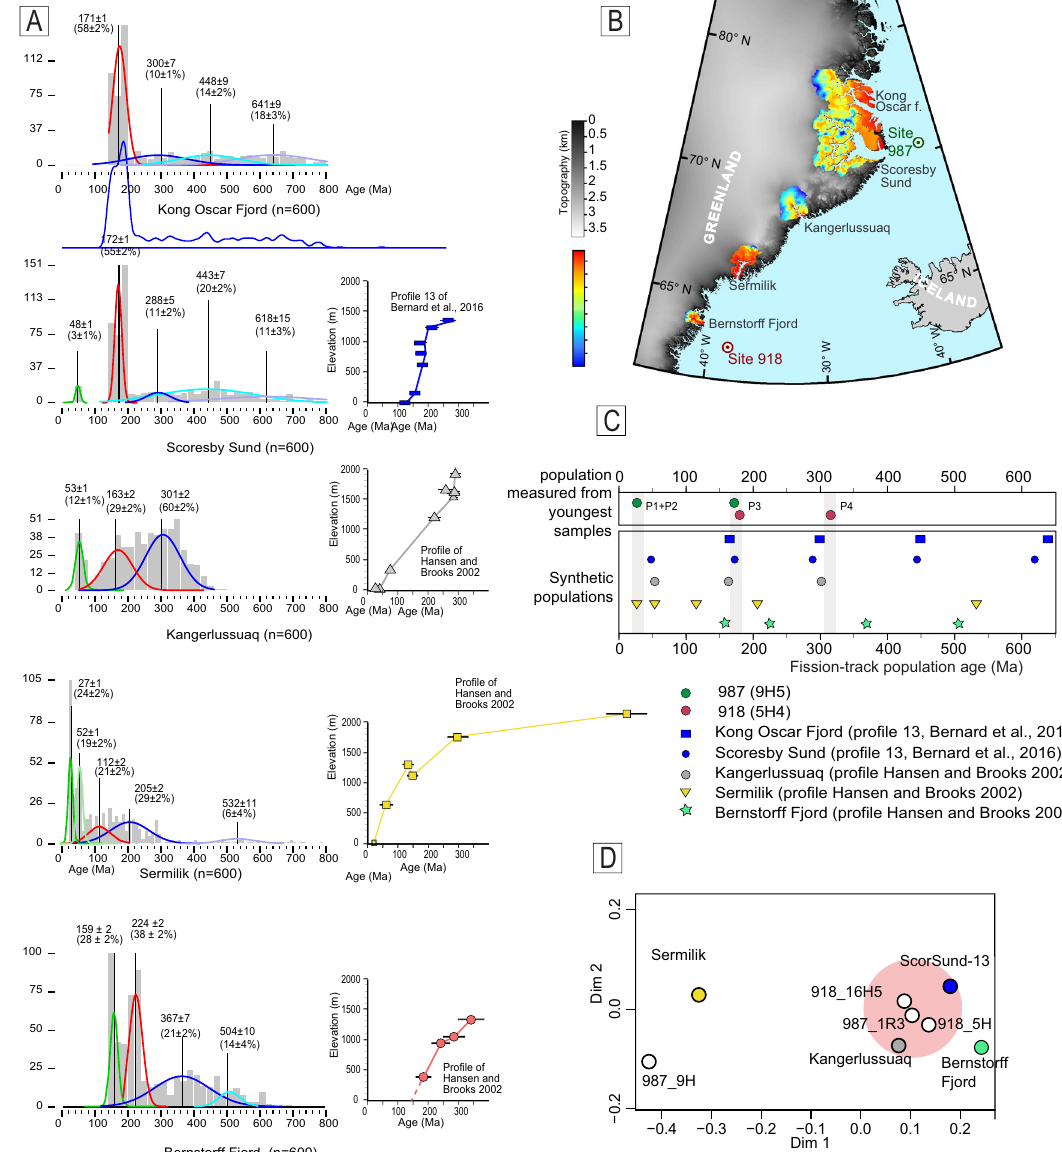
Figure 3. ( A ) Synthetic age distribution and populations for the five drainage areas. Histograms of the synthetic ages are shown in grey in the background; the age populations after decomposition are shown in colour. Vertical black lines and numbers represent the position of the populations, age and proportion with uncertainties (from Density Plotter 22 ). Age-elevation profiles used to calculate synthetic age distribution are shown nearby. Profiles are vertically aligned to indicate the differences. For Scoresby Sund and Kong Oscar Fjord, the same elevation- age profile is used. ( B ) Map of southeastern Greenland, which shows drainage areas used to calculate the synthetic age distributions. The distribution of the synthetic age is shown in colour. The map was created using ArcMap 10.5 software. ( C ) Comparison of the age of the measured population of the two youngest samples (middle Pleistocene) with that of the synthetic populations. Populations form Kong Oscar Fjord, Scoresby Sund, and Kangerlussuaq match well with the measured P3 and P4 populations, which are marked in grey. ( D ) MDS plot, where the distance between the samples reflects the similarity of the distribution. The entire distribution is considered, and not just the age of a single population. The plot shows that three of the youngest measured samples are similar to the synthetic samples of Scoresby Sund and